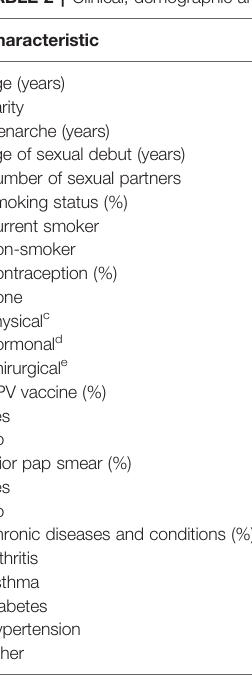
TABLE 2 | Clinical, demographic and risk factors associated with HPV